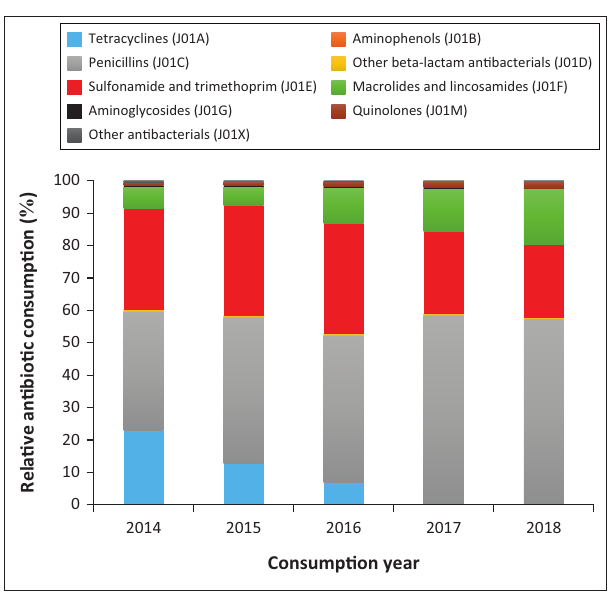
FIGURE 1: Relative antibiotic consumption at anatomical therapeutic chemical level